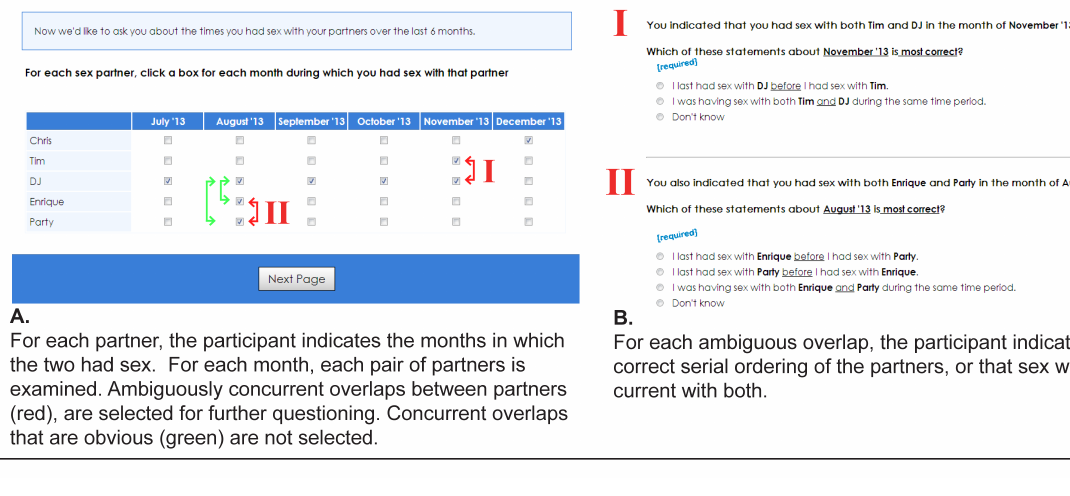
Focus Group and Facebook